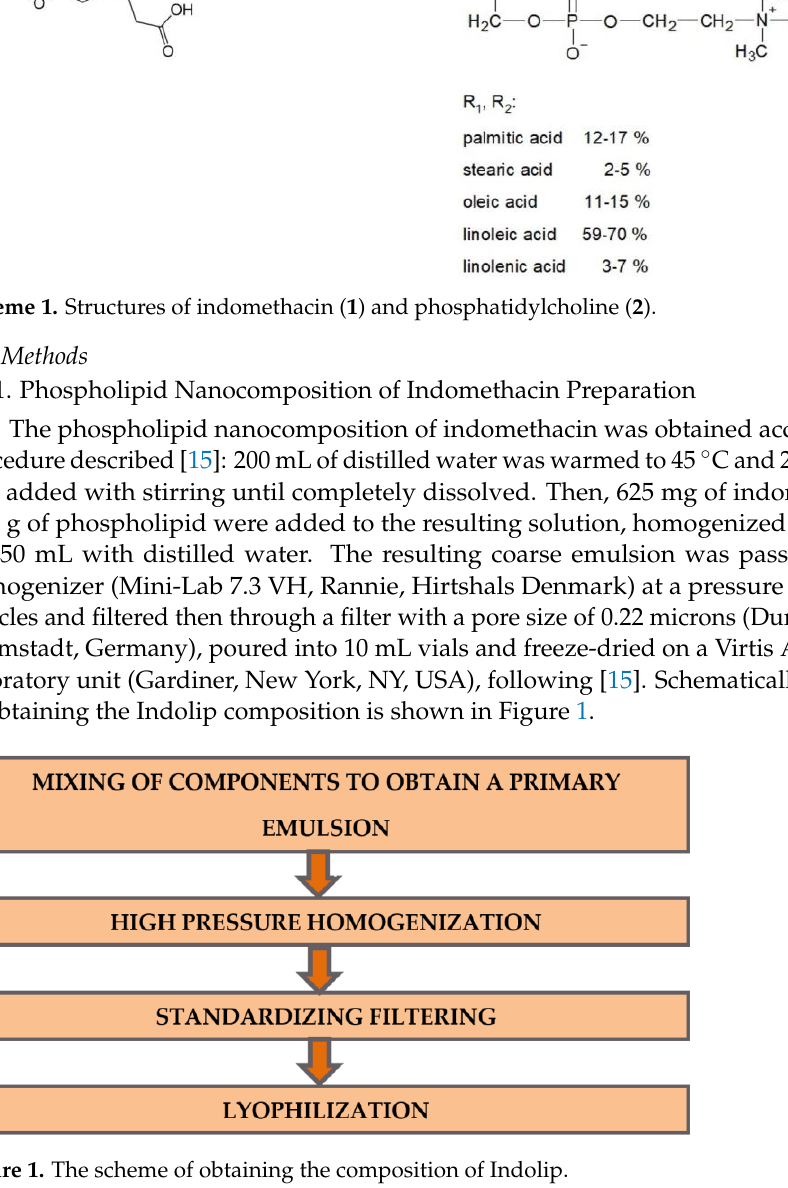
Figure 1. The scheme of obtaining the composition of Indolip.